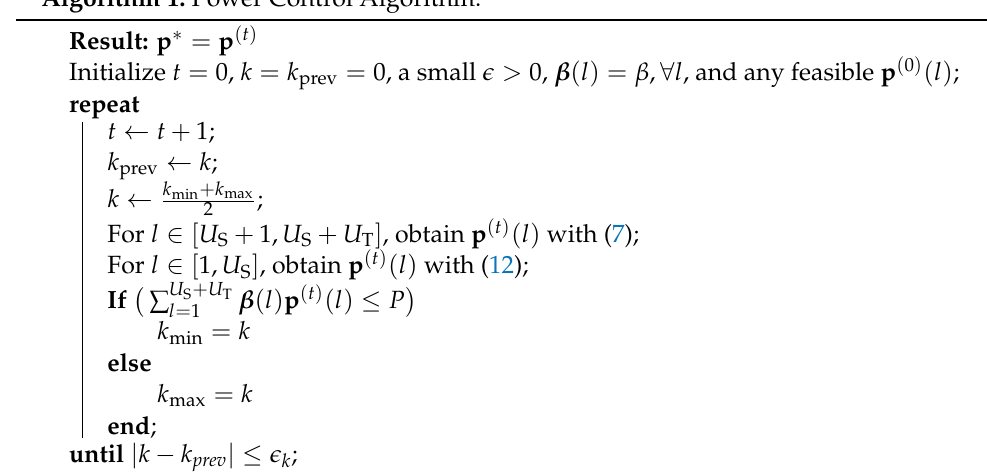
Algorithm 1: Power Control